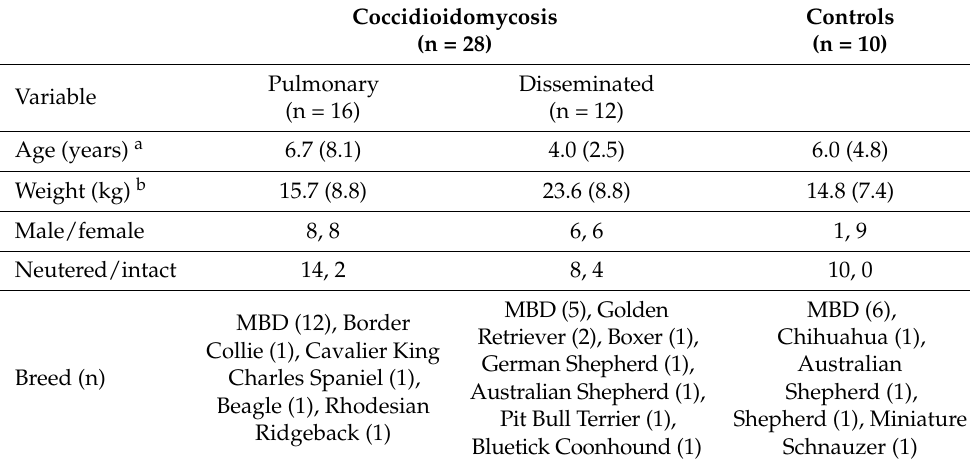
Table 1. Demographic data for 28 dogs with coccidioidomycosis and 10 healthy control